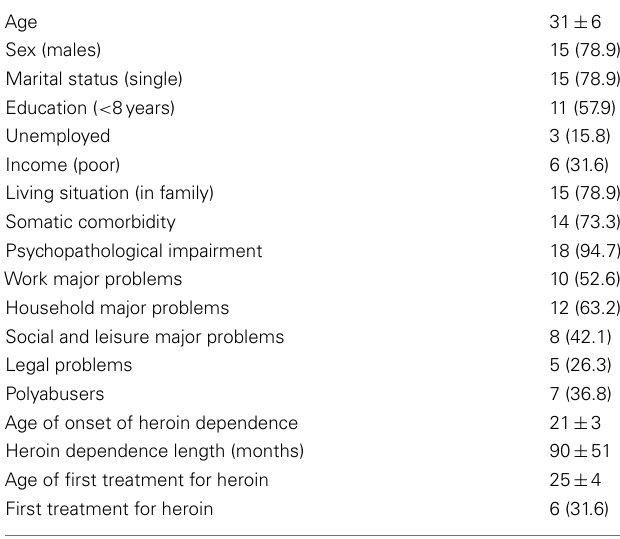
Table 1 | Demographic and clinical